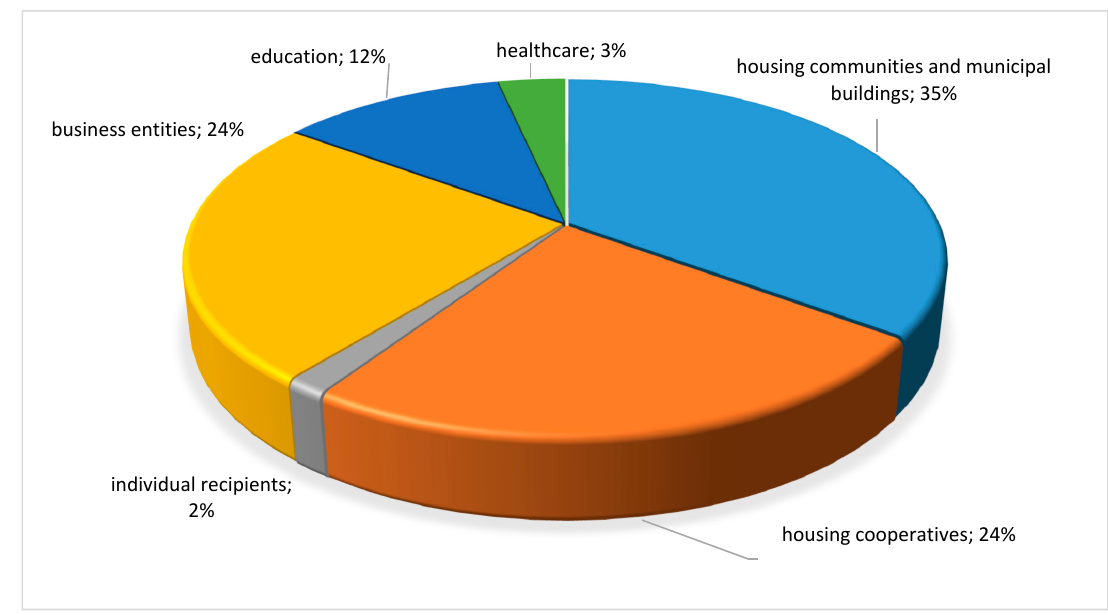
Figure 2. The structure of heat consumers in Krakow, taking into account the ordered thermal capacity in 2018 (adapted with permission from ref. [30]. Copyright 2021 MPEC S.A.).